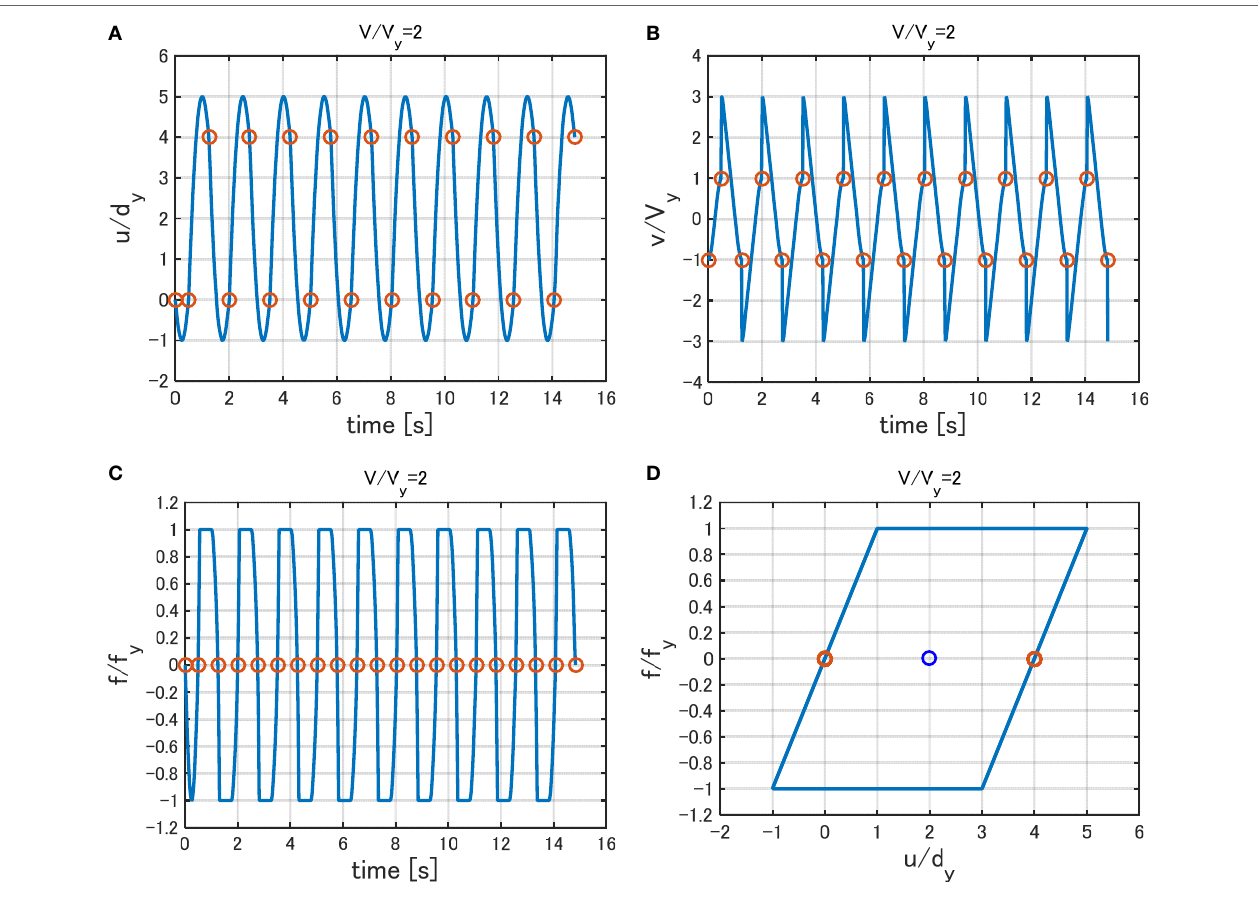
FigUre 10 | response to input sequence 2 for V / V y = 2: (a) displacement, (B) velocity, (c) restoring force, and (D) force–deformation relation